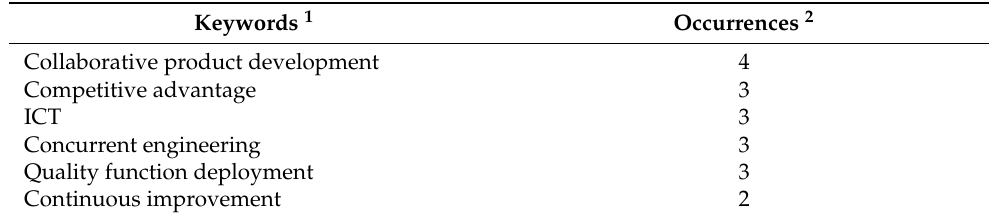
Table 5. Keyword’s analysis.